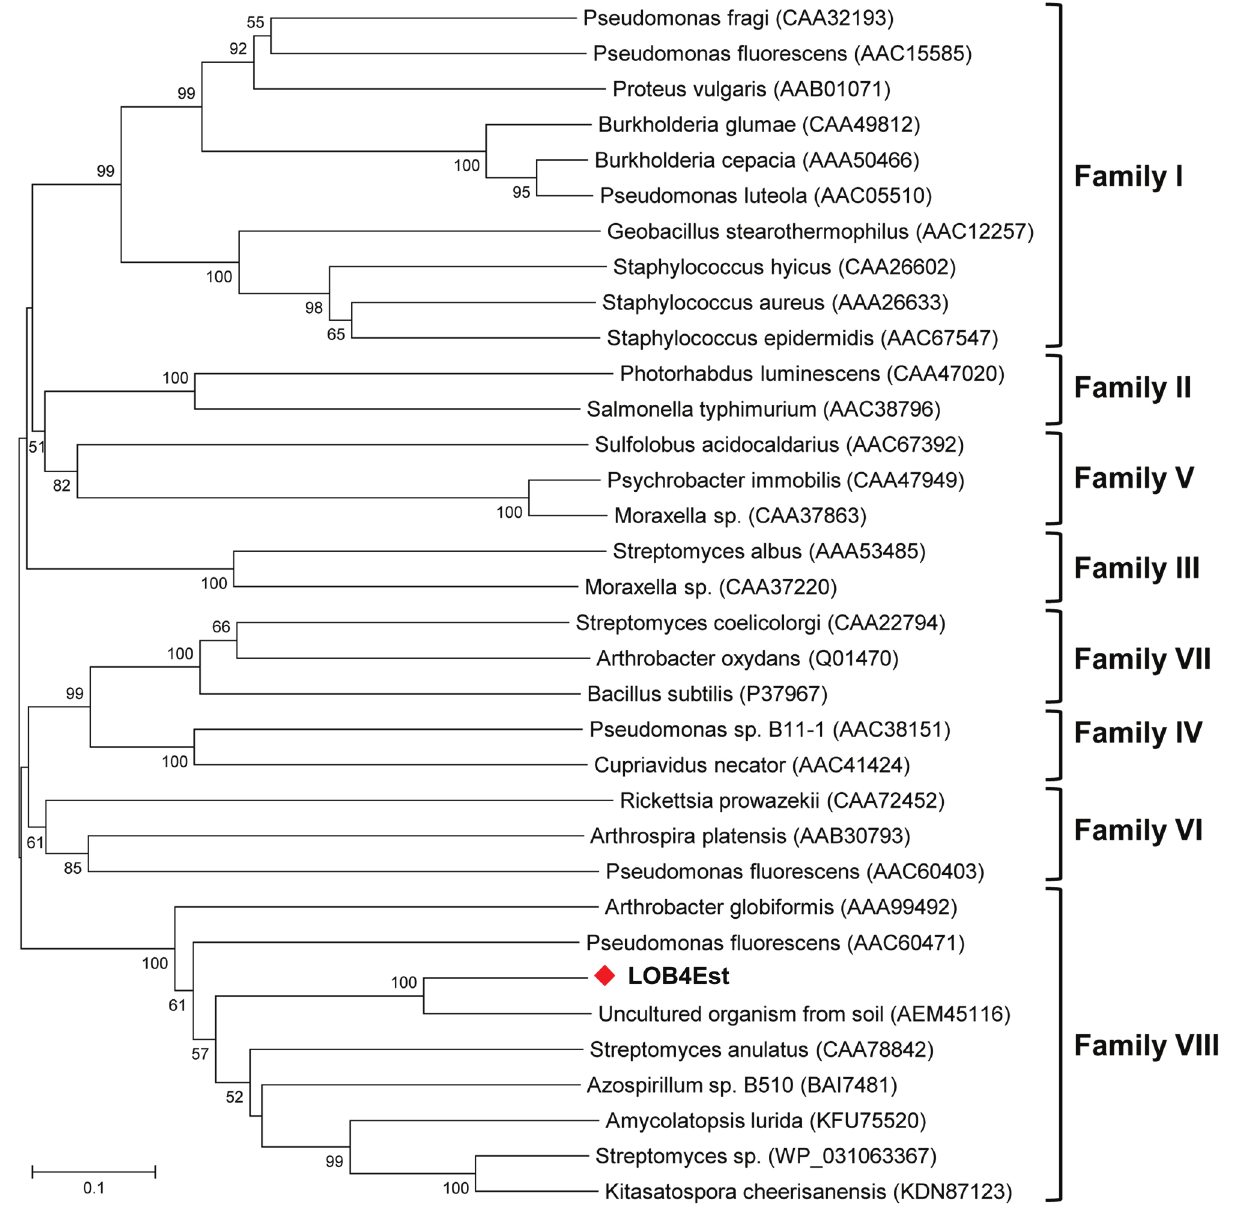
FIGURE 5 | Neighbor-joining phylogenetic tree based on amino acid sequence of the LOB4Est (shown in bold) and known members of lipase families I-VIII (Arpigny and Jaeger, 1999). GenBank accession numbers of the reference sequences are shown in parentheses. The tree was drawn using MEGA software, with p-distance model and 1000 bootstrap replications. Only bootstrap values > 50 are